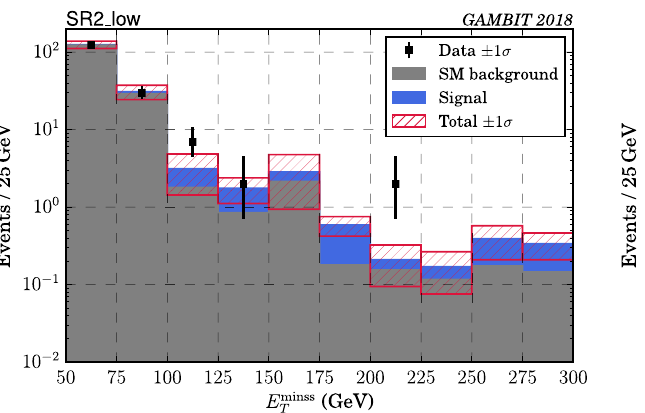
Fig. 11 Distribution of missing transverse energy in the 2 lepton plus jets signal regions of the traditional ATLAS multilepton analysis, after applying all selection requirements. The grey bars show the total SM background (taken from Ref. [116]) and the stacked blue bars show the signal for our best-fit point. The hatched red bands show the 1 σ uncer-